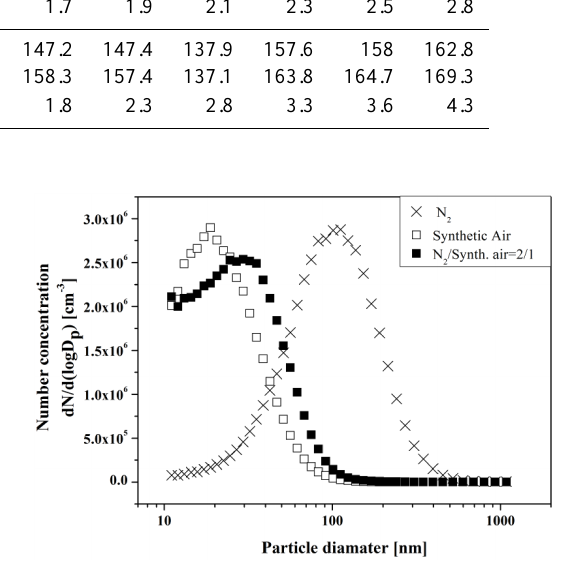
Figure 6. Number size distribution of the laser ablation-generated carbonaceous particles by applying different carrier gases with a volumetric flow rate of 500cm 3 min − 1 at 2Jcm − 2